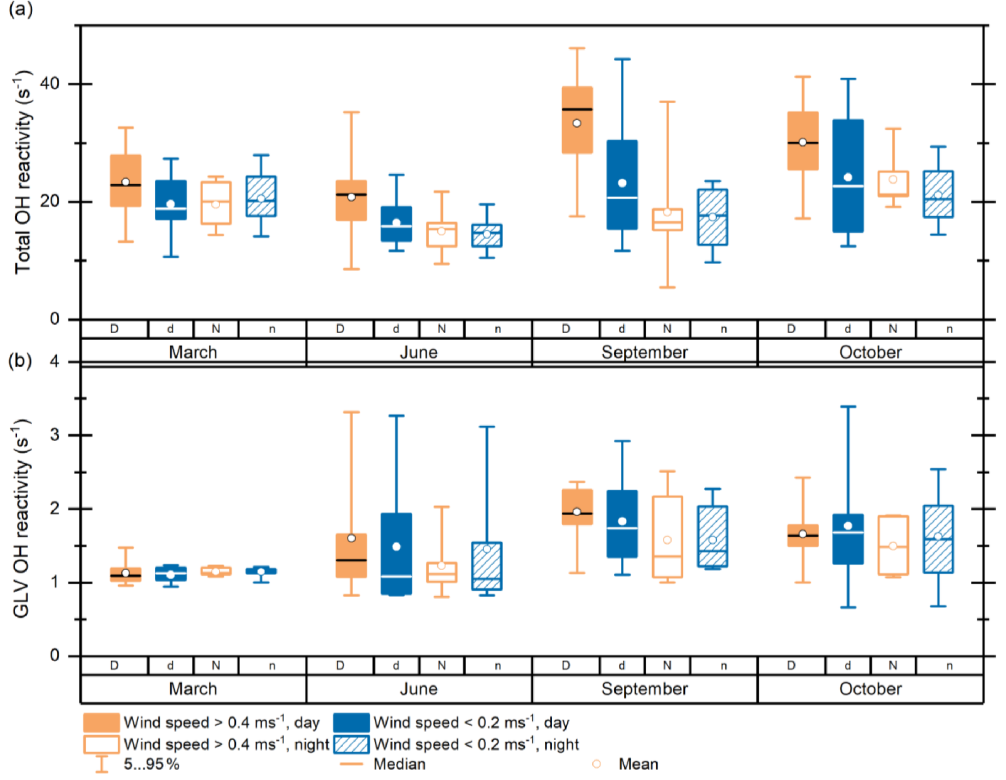
Figure 8. (a) Total OH reactivity at 80ma.g.l. at the ATTO tall tower for two dry seasons (September 2019, October 2018), one wet season (March 2018), and one wet–dry transition season (June 2019), categorized by a wind index. Categories: D is wind speed at 26m > 0.4ms − 1 , daytime; d is wind speed < 0.2ms − 1 , daytime; N is wind speed > 0.4ms − 1 , nighttime; n is wind speed < 0.2ms − 1 , nighttime. The boxes include the 25th–75th percentiles and the whiskers the 5th–95th percentiles. (b) Same as (a) but for calculated OH reactivity of total green leaf